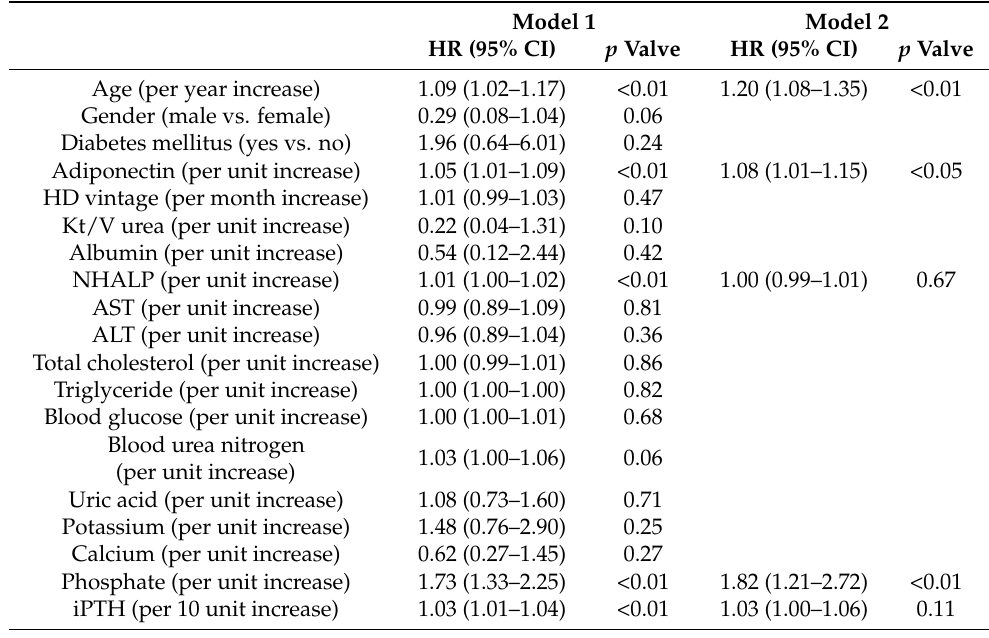
Figure 1. Cumulative event-free survival curves of bone fracture risks among patients with respect to the higher and lower concentration groups of adiponectin over 2058 person-months of follow-up. The blue line denotes patients with adiponectin concentration < 11.15 ug/mL. The green line denotes patients with adiponectin concentration > 11.15 ug/mL. Table 3. The associations between adiponectin and other clinical risk factors for bone fracture events in the Cox proportional hazard regression